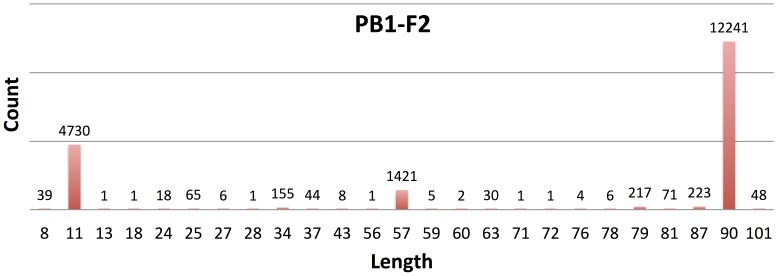
Length variability of PB1-F2.Of 19,378 PB1 sequences analyzed, 19,339 contain a start codon at position 95, signaling the beginning of the PB1-F2 ORF. The downstream stop codons vary, resulting in different ORF sizes. The 3 major PB1-F2 lengths are 90, 57 and 11 aa. It is generally assumed that an intact PB1-F2 is ≥79 aa in length.